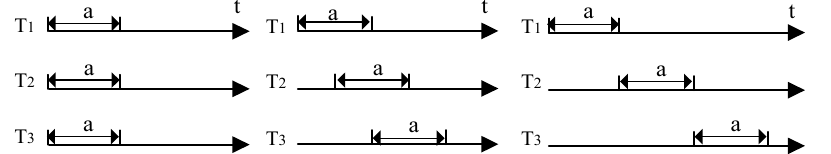
Figure 13. Distribution of interceptable time windows.